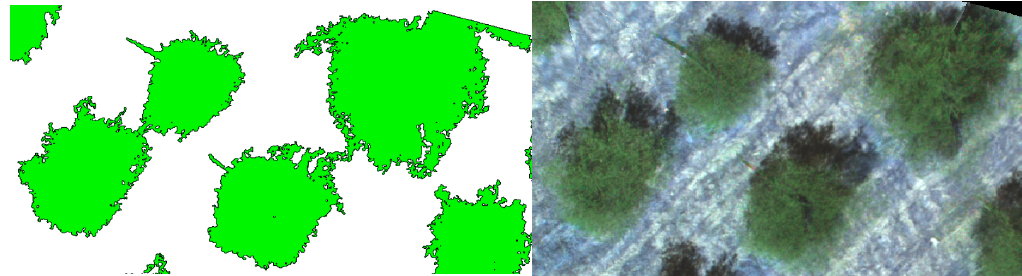
Figure 8. Incorrect objects identification (closer objects).